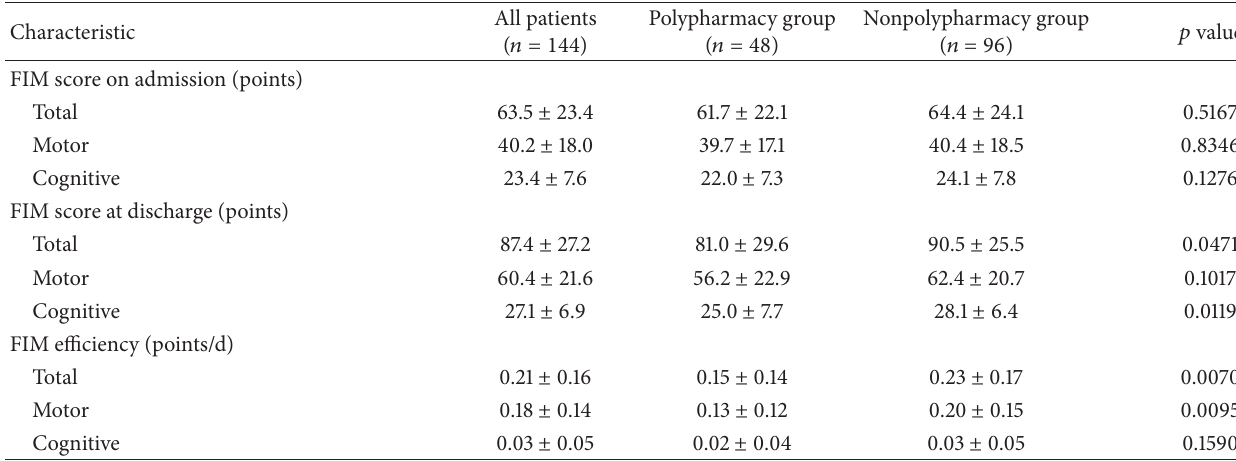
Table 2: Comparison of FIM score upon admission and at the time of discharge and FIM efficiency.